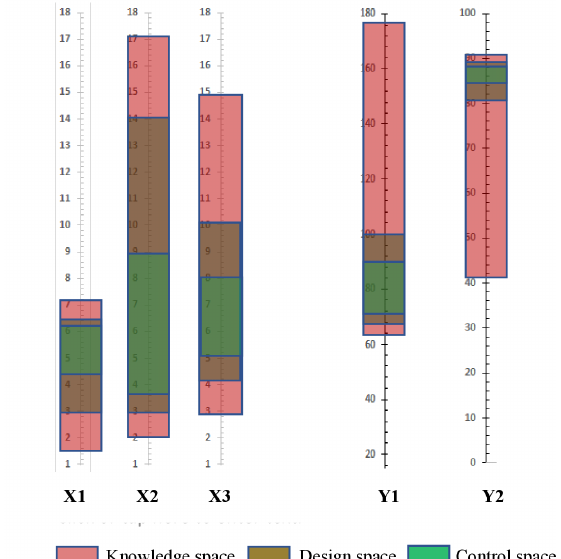
Figure 4. Knowledge space, design space, and control space between input factors (CMAs and CPPs) and CQAs represented on the hypothetical scale. X1: surfactant (%); X2: ST (min); X3: total Lipid (%); Y1: size (nm); Y2: EE